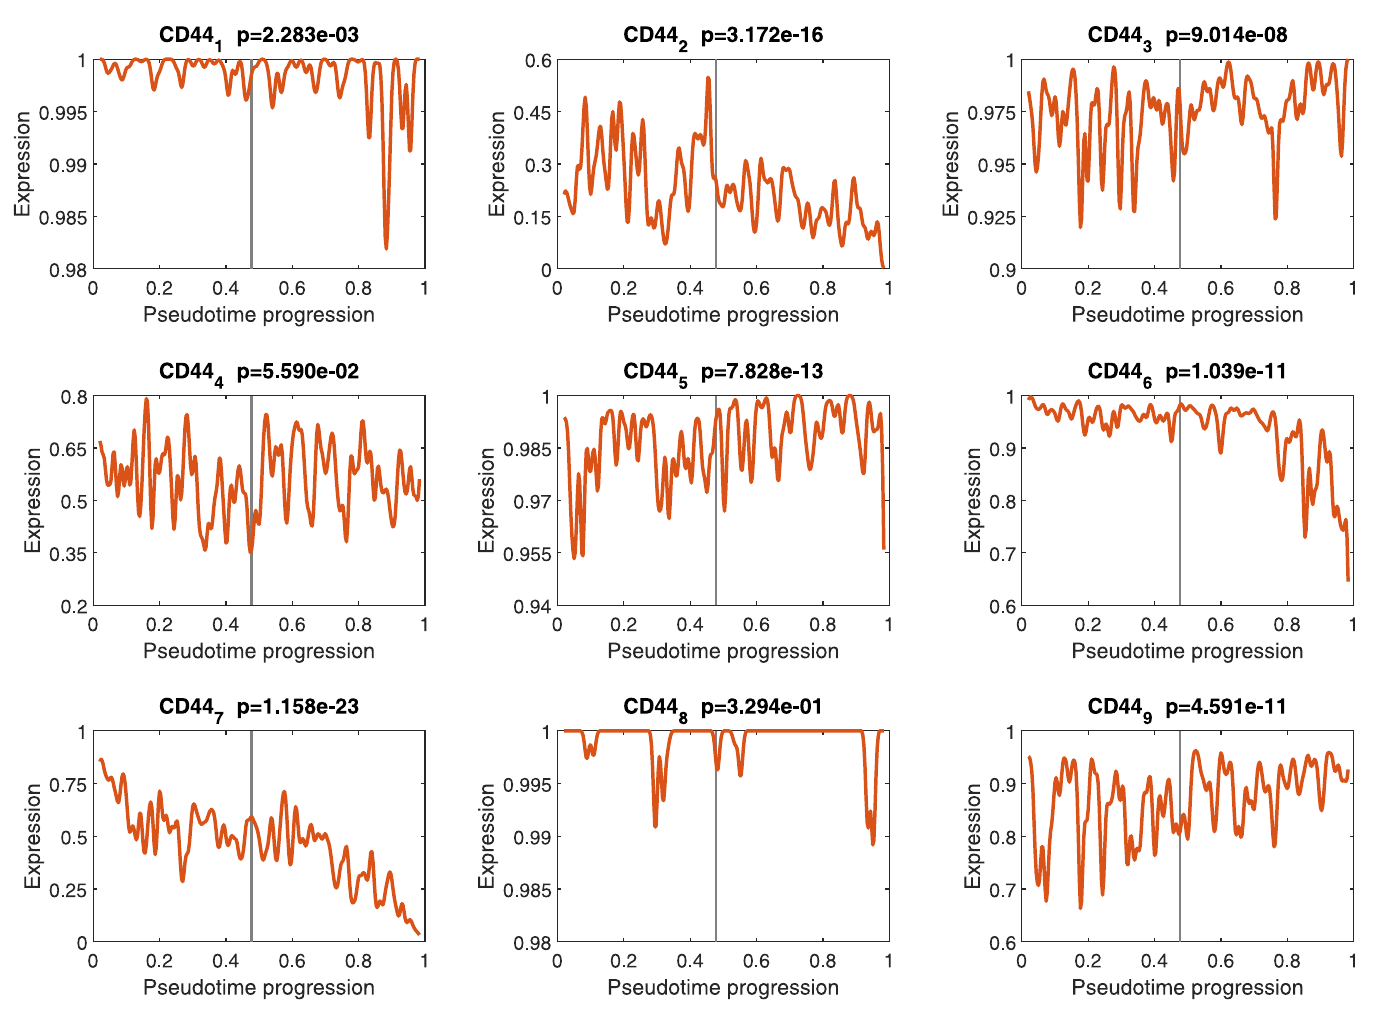
Fig 8. Reconstructed expression dynamics of alternative splicing events of the CD44